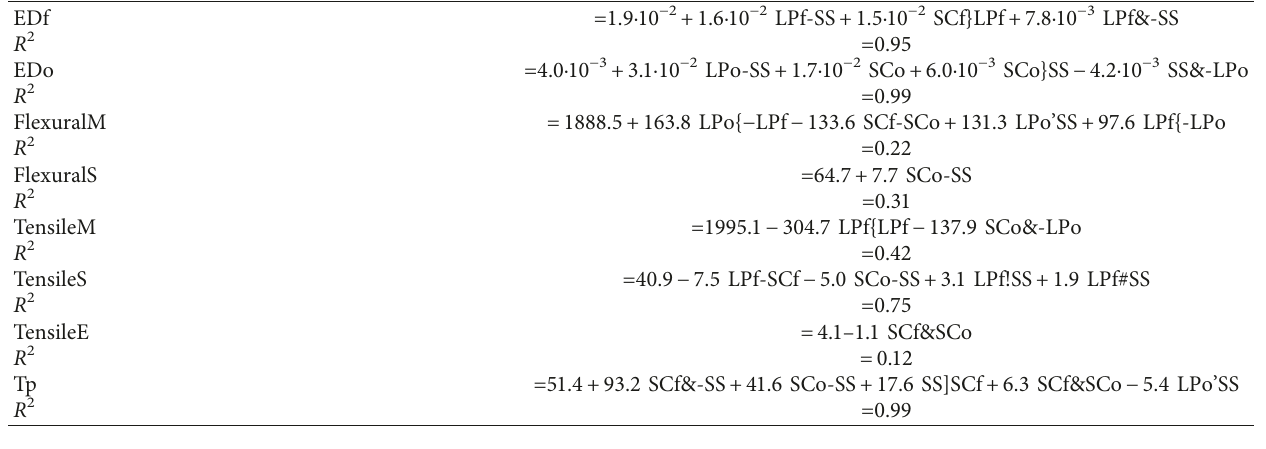
Table 5: Models of CORICO for 5 regressors.